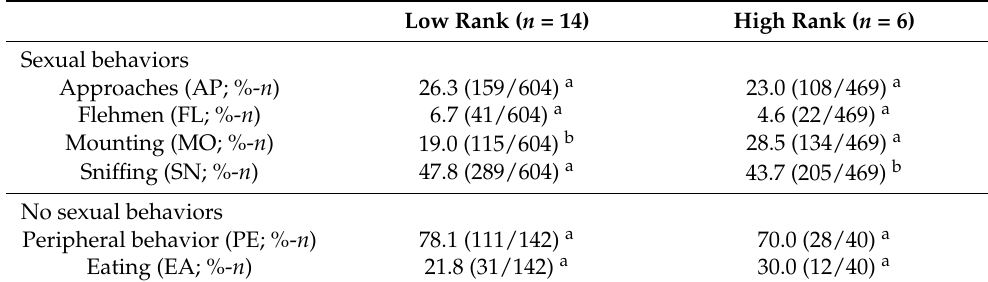
Table 2. Sexual and non-sexual behaviors of LHR and HHR shown in the competition tests during the non-breeding season.